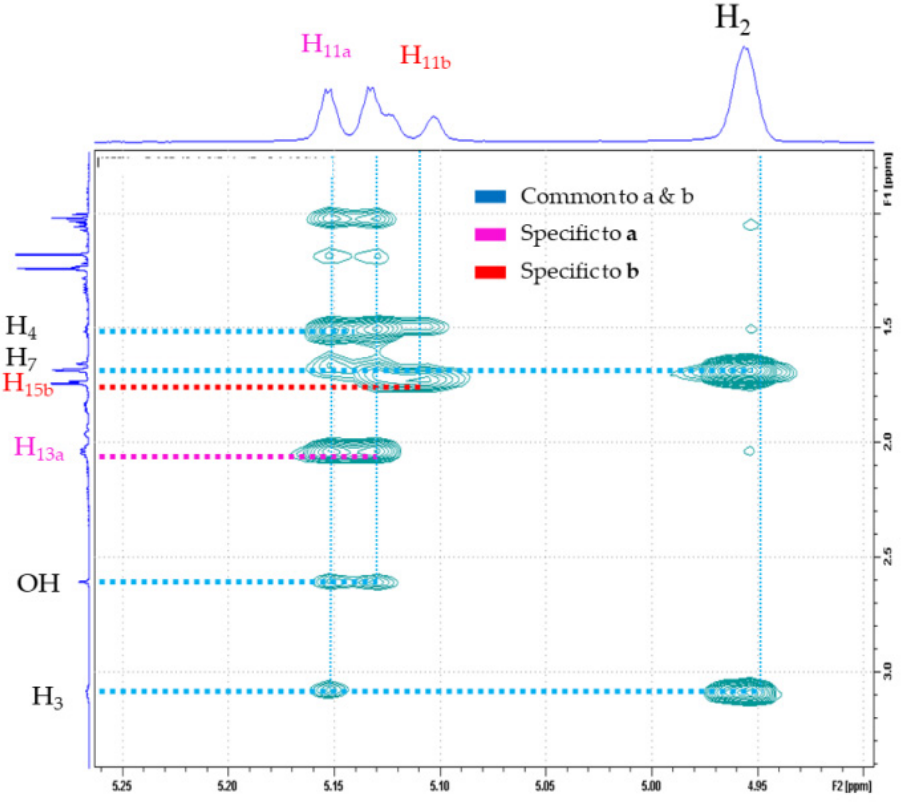
Figure 5. Zoom of NOESY spectrum showing specific correlations used to resolve stereochemistry of the acyclic double bond in 42a,b .